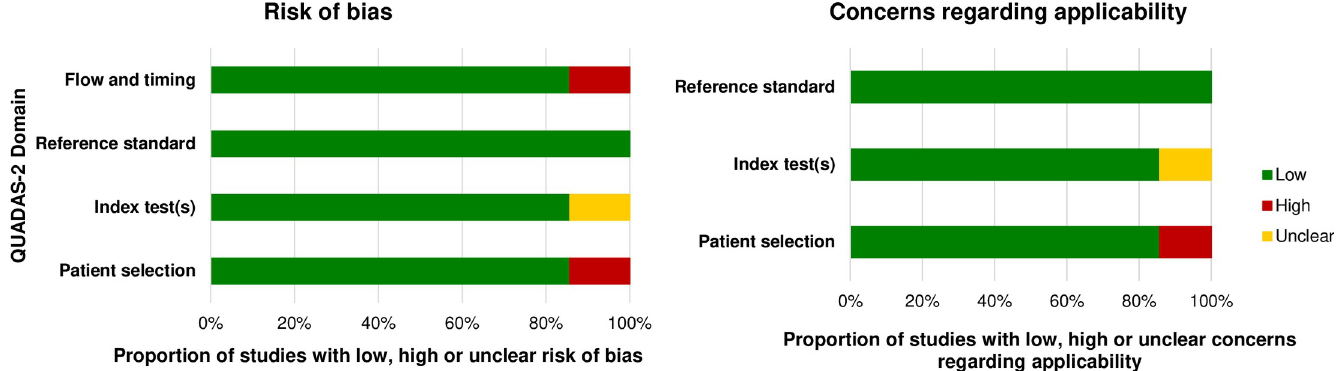
Fig 3. Proportion of studies on imaging diagnostics with low, high or unclear risk of bias and concerns regarding applicability assessed using the QUADAS-2 tool.